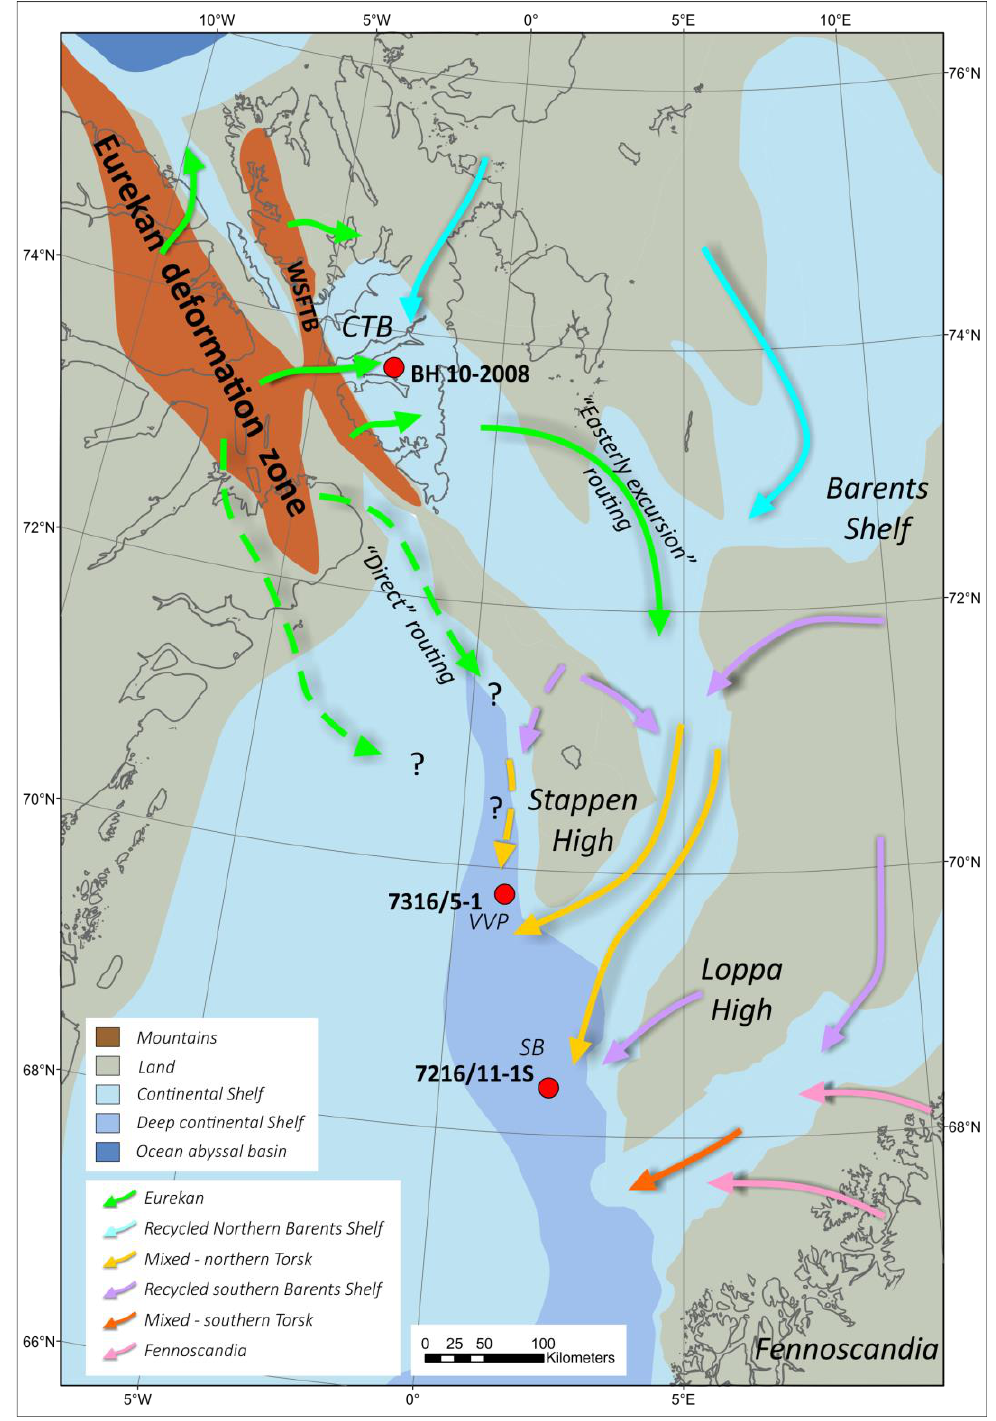
Figure 12. Schematic Eocene palaeogeography adapted from Blakey [4], Smelror, Petrov, Larssen and Werner [5], Helland-Hansen and Grundvåg [9] and Lasabuda, Laberg, Knutsen and Høgseth [19] showing possible Eocene sediment routing on the western Barents Shelf, based on a 50 Ma GPlates reconstruction [115]. Direct and less certain routing from the terrains exhumed during Eurekan deformation are shown as dashed arrows, whereas more certain Eurekan-derived sediment pathways are shown as solid lines. CTB = Central Tertiary Basin, SB = Sørvesstnaget Basin, VVP = Vesybakken Volcanic Province and WSFTB = West Spitsbergen fold-and-thrust Belt. The provenance data presented here is consistent with a fill and spill model for the Central Tertiary Basin [9] is consistent with the provenance data (Figure 12). More direct